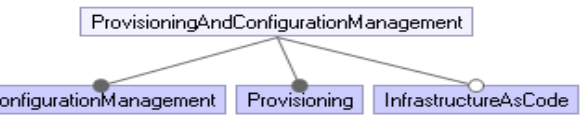
Figure 9. Feature diagram of provisioning and configuration management.